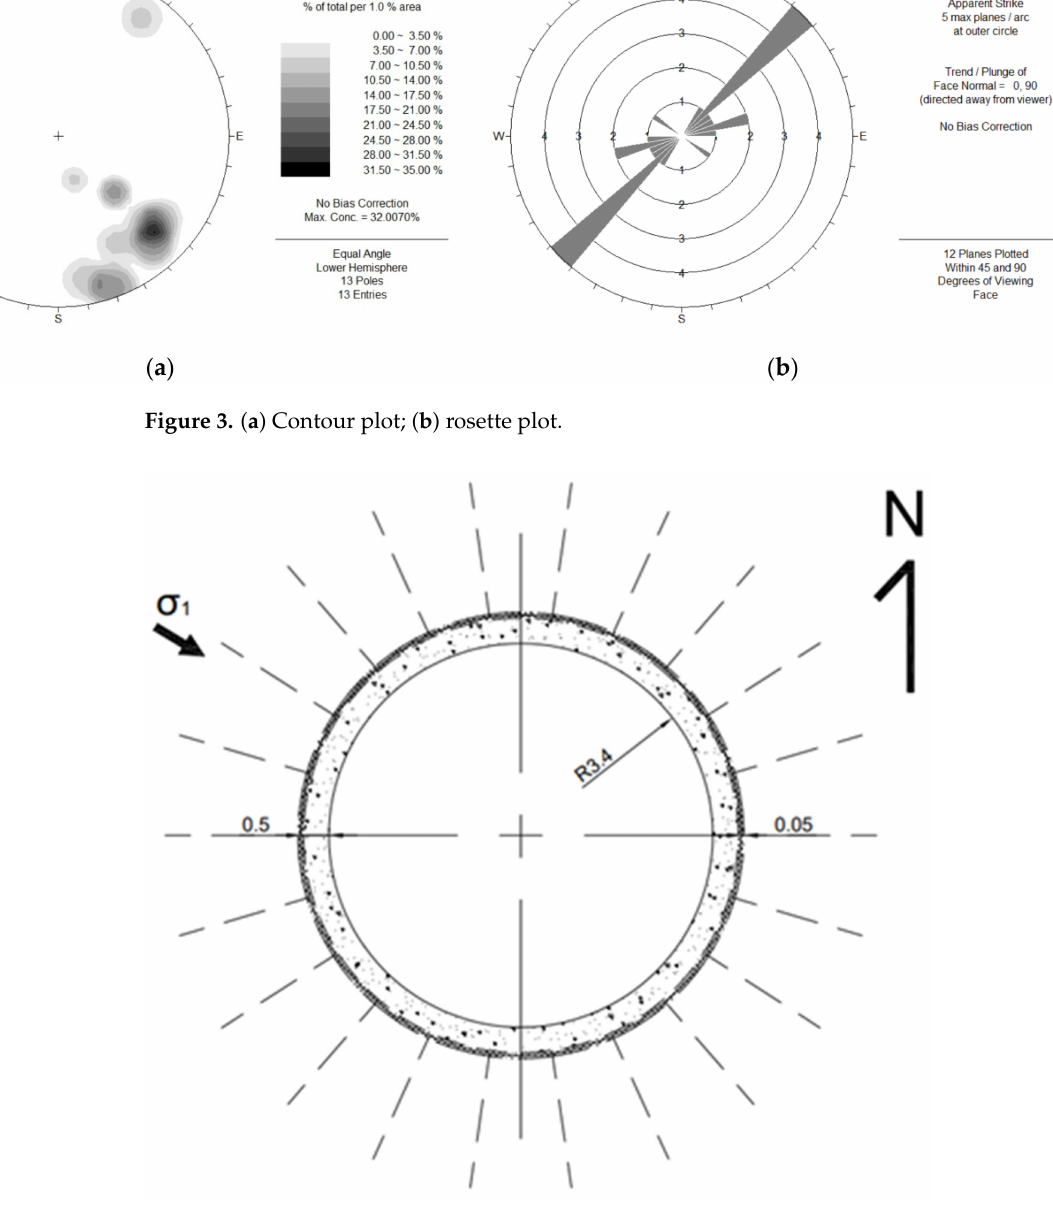
Figure 4. Direction of maximum horizontal principal stress of the shaft. Rock samples with good integrity were collected from the main shaft at − 1465